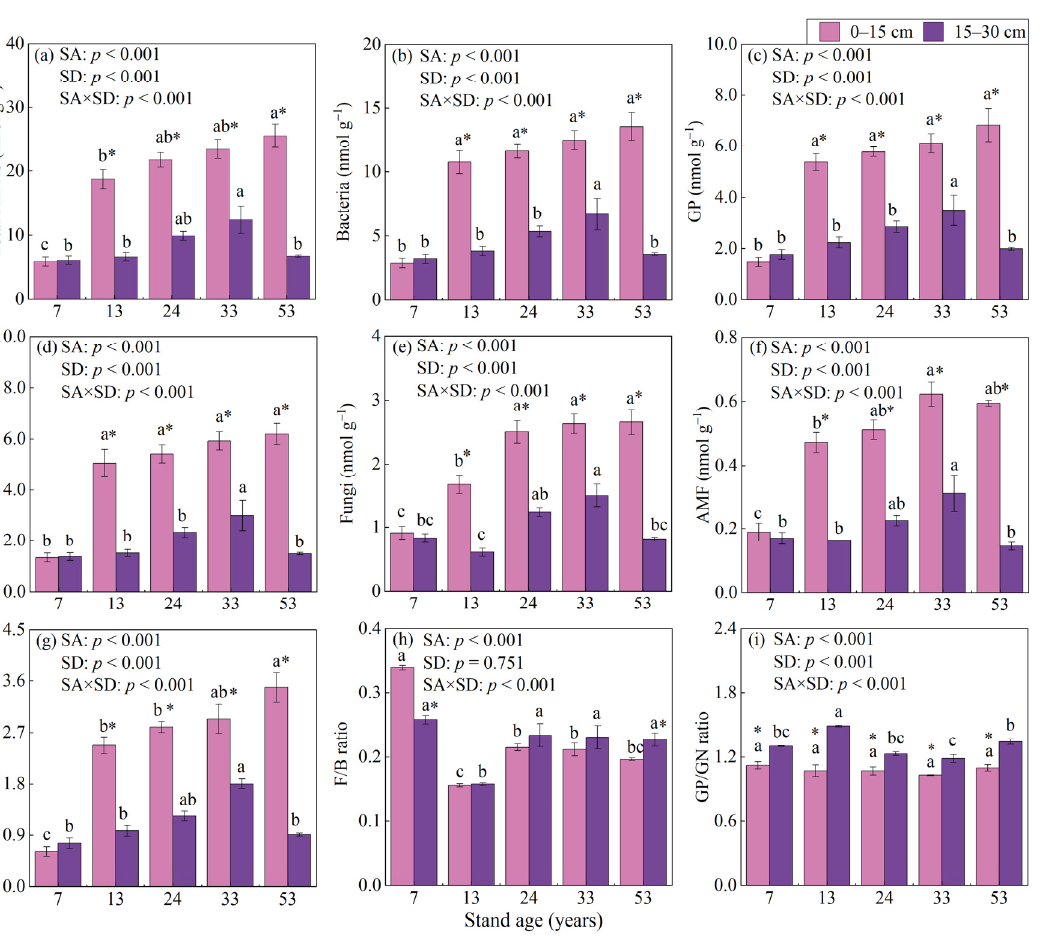
Figure 1. The biomass of ( a ) total phospholipid fatty acids (PLFAs), ( b ) bacteria (B), ( c ) Gram-positive bacteria (GP), ( d ) Gram-negative bacteria (GN), ( e ) fungi (F), ( f ) arbuscular mycorrhizal fungi (AMF), and ( g ) actinomycetes (ACT), ( h ) the F/B ratio, and ( i ) the GP/GN ratio from the 0–15 cm and 15–30 cm soil depths along the stand ages in the Chinese cedar plantations. Different lowercase letters denote statistically significant differences between forest ages at the same soil depth ( p < 0.05). Significant changes between two soil depths of the same stand age are denoted by the asterisk ( p < 0.05). Each sub ‐ figure contains the results of a two ‐ way ANOVA for the primary components (stand age (SA) and soil depth (SD)) and their interactions (SA × SD). Bonferroni was employed for main effect comparisons or post hoc analyses of simple effects. The bars show mean ± SE ( n = 3).